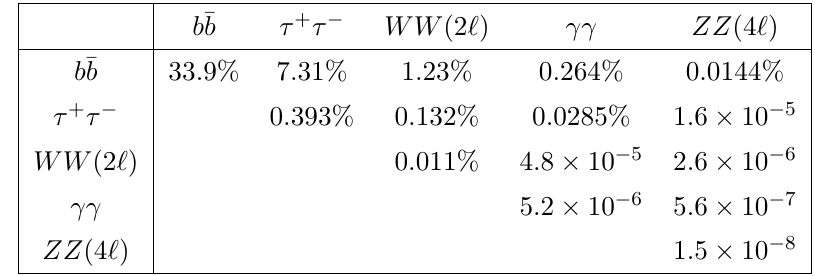
Table 2. Branching ratios for some important hh decay modes (based on [43]), where the (cid:12)rst (second) higgs decay is shown in the row (column). The entries are symmetric along the